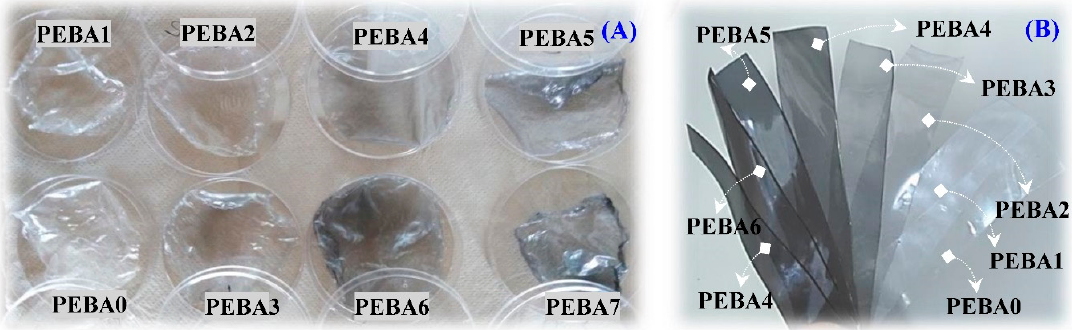
Figure 3. Images of ( A ) the synthesized GA/PEBA membranes and ( B ) the prepared GA/PEBA mechanical samples.